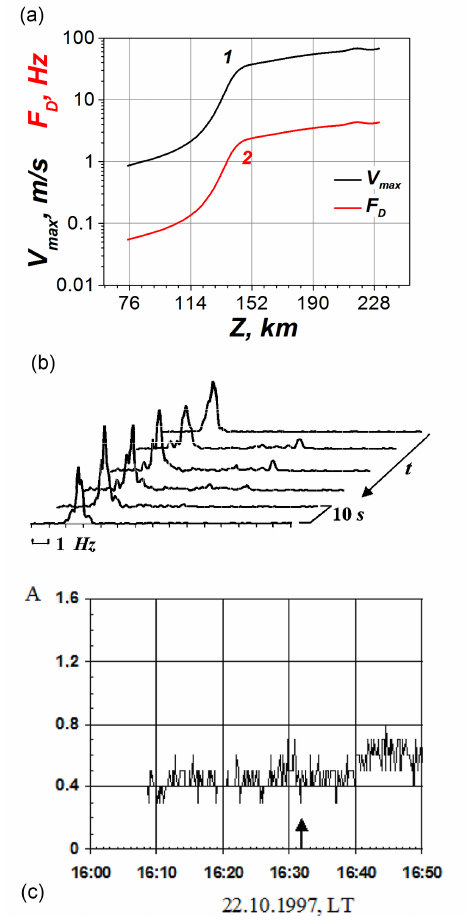
Figure 4. Panels (a) and (b) are experimental results on the mea- surements of the signal scattered from ionospheric inhomogeneities. Panel (a) shows the time dependences of the envelope of the scat- tered signal. The beginning of the acoustic irradiation is marked by an arrow. Panel (b) shows the spectra of the power of the scattered signal and (c) the simulation results. V max is the maximum velocity of the air in ULF acoustic waves (curve 1) and F D is the Doppler shift due to ULF acoustic wave (curve